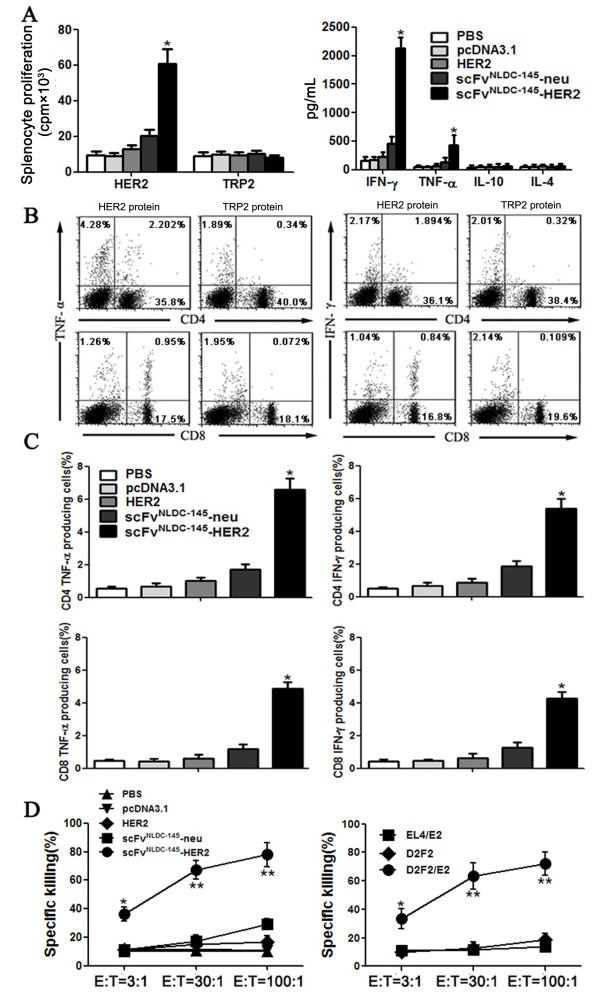
Vaccination with scFvNLDC-145-HER2 induced HER2-specific cellular immune response. BALB/c mice were vaccinated with HER2, scFvNLDC-145-neu or scFvNLDC-145-HER2. Control animals received PBS or pcDNA3.1. Spleens and peripheral blood were harvested from the vaccinated animals after two vaccinations. A splenocytes isolated from the vaccinated animals were cultured in the presence of 10 μg/mL recombinant HER2 or TRP2 protein for 4 d with the addition of [3H] thymidine in the last 16 h. T-cell proliferation was determined by [3H] thymidine incorporation (left panel). Right panel, the supernatant recovered from the assay in left was tested for cytokine production by ELISA. B intracellular staining for IFN-γ and TNF-α in splenocytes from the vaccinated animals stimulated with 10 μg/mL recombinant HER2 or TRP2 protein for 24 h and brefeldin A added during the final 4 h of incubation. One representative dot plots from scFvNLDC-145-HER2-vaccinated animal. C percentage of CD4+TNF-α+, CD4+IFN-γ+, CD8+ TNF-α+ and CD8+ IFN-γ+ cells in total CD4+ and CD 8+ T cells from each group are shown. The data are mean percentages ± SE. D splenocytes were cocultured with D2F2/E2 cells for 5 d. The resultant splenocytes (E) were cocultured for 4 h with the 51Cr-labeled target cells (T) (left panel). Right panel, the restimulated splenocytes from scFvNLDC-145-HER2 vaccinated mice were also cocultured for 4 h with the 51Cr-labeled D2F2 or EL4/E2 (different gene background control) target cells. Percentages of target cells killing by the splenocytes from the vaccinated mice are shown. Data represent the means of triplicate cultures and are representative of two independent experiments. Bars, SE. *, P < 0.01, **, P < 0.001, scFvNLDC-145-HER2 compared with other groups.